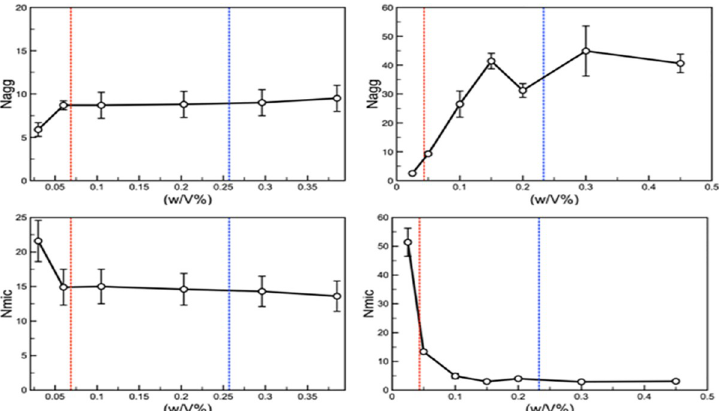
Fig 2. The average number of Pluronic molecules found in a micelle (N agg ) and the number of micelles in our system (after they have equilibrated) (N mic ) as a function of the concentration of the Pluronics in the system for both the F68 (left) and P105 (right)